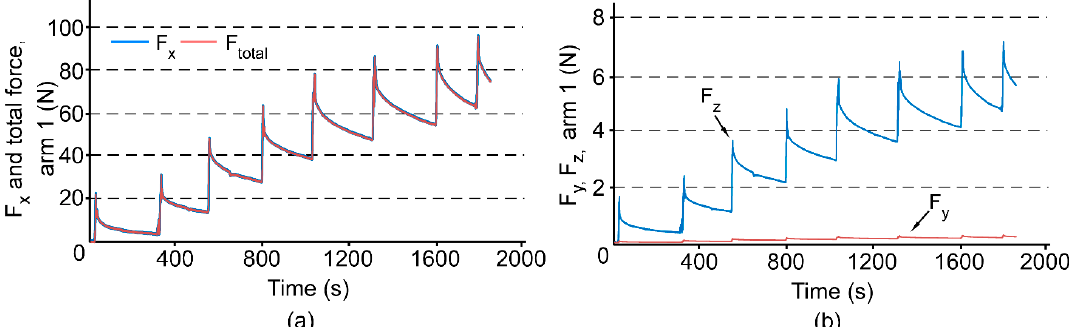
Figure 4. ( a ) Total force ( F total ) and force along x axis ( F x ), and ( b ) F y and F z on the sensor arm (arm 1) for a total of eight turns of the jackscrew. F x is dominant component of the total force and F y is negligibly small.